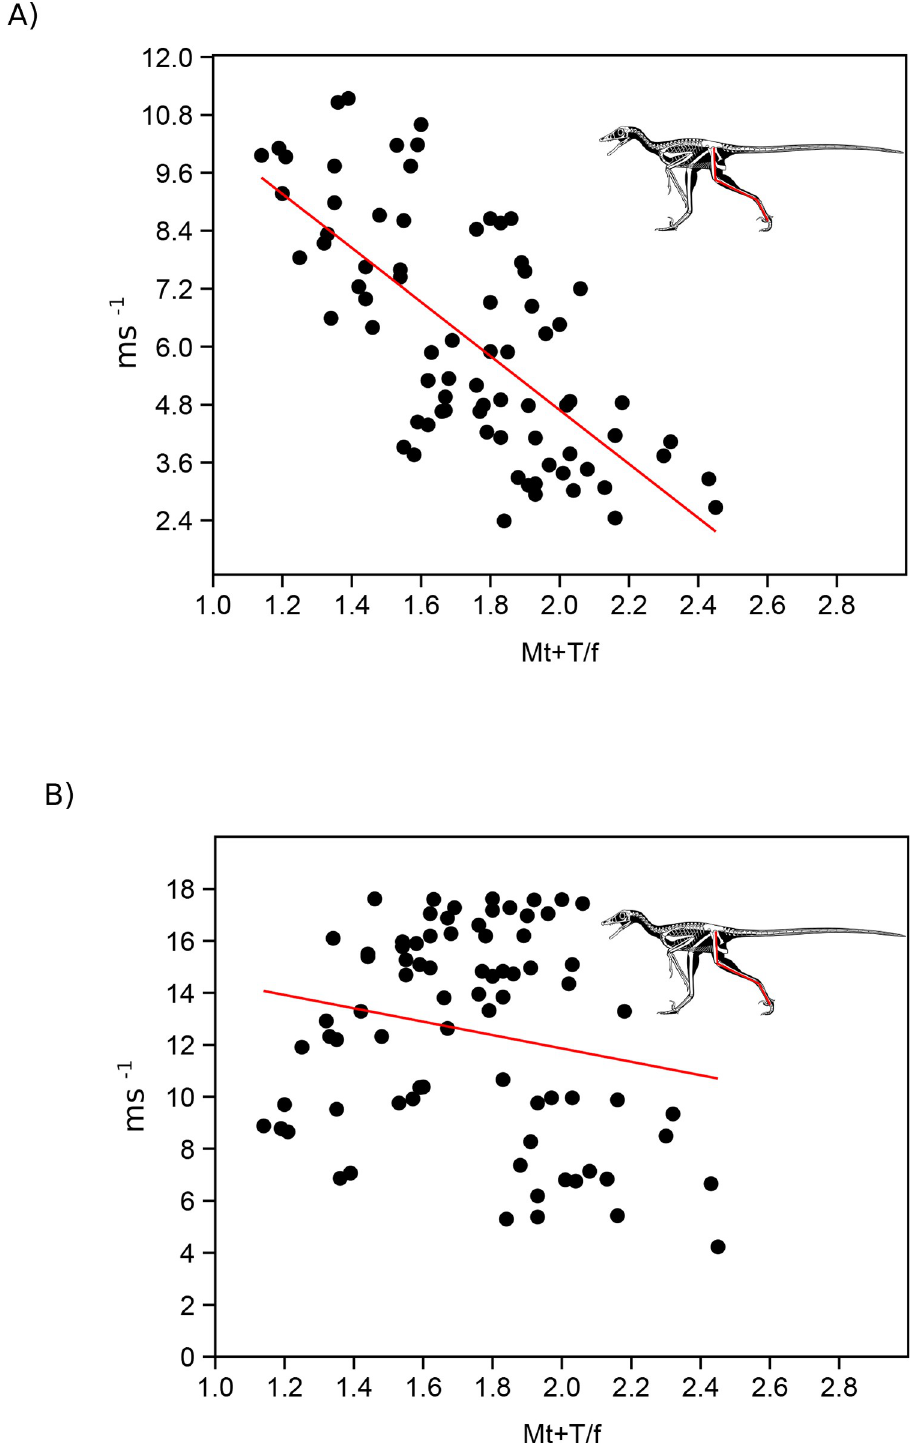
Fig 4. Comparing proxies to running speed estimates using larger hindlimb database. Evaluation of the fit of the distal limb index proxy to estimated top speed at Froude = 5 (A) and using the mass induced limitation as proposed in [7] in the larger hindlimb dataset (S4 Table). Skeletal image of Microraptor modified from the illustrations of S. Hartman.